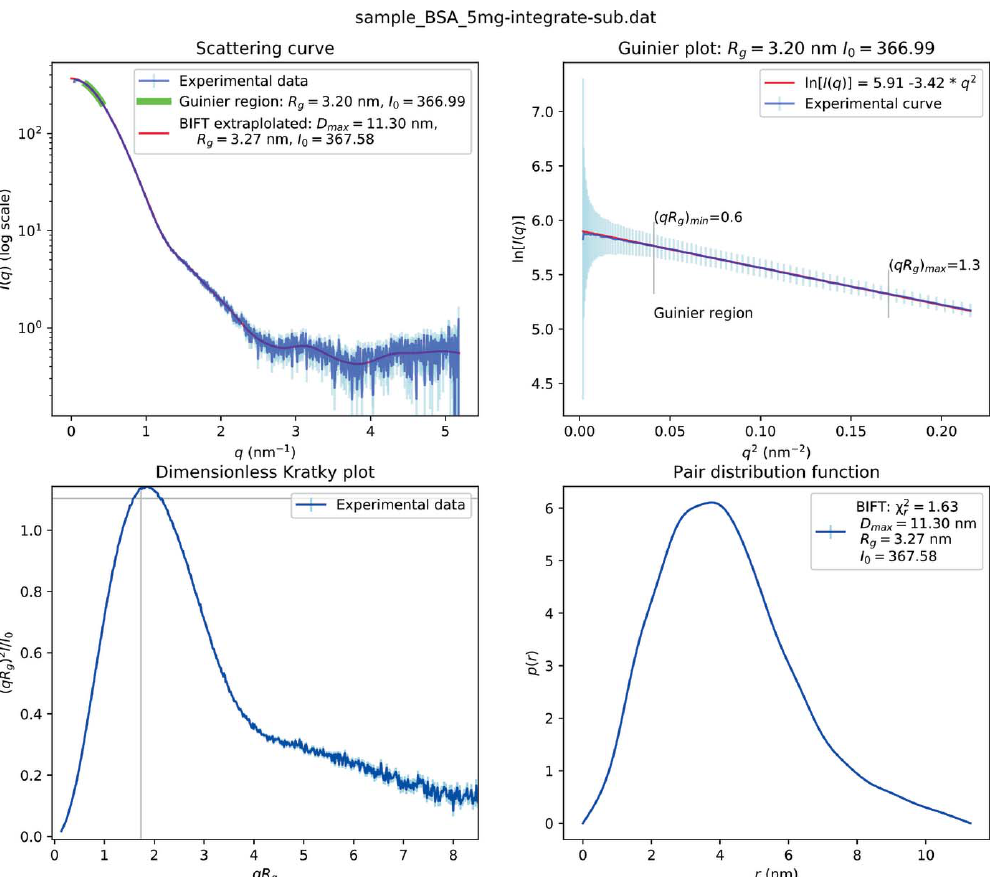
Figure 1 Default visualization of BioSAS data using the FreeSAS tool on a three-column ( q , I and (cid:5) ) ASCII file – here bovine serum albumin (BSA) acquired with 12.5 keV photons. The top-left plot presents the classical I = f ( q ) plot on a semi-logarithmic scale with the Guinier region highlighted in green and IFT- based curve superimposed in red. Those results come from the Guinier analysis (top right) based on a linear fit of log( I ) = f ( q 2 ) and from the pair distribution function [ p = f ( r )] obtained from the BIFT analysis (bottom right). A dimensionless Kratky plot is presented in the lower-left